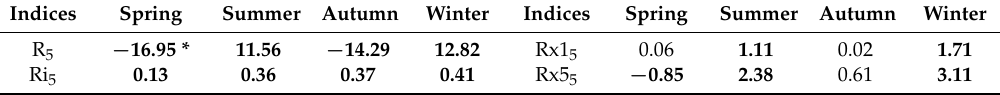
Table 5. Trends for the 5-year return levels for the four precipitation indices (mm · year − 1 · decade − 1 ). Indices Spring Summer Autumn Winter Indices Spring Summer Autumn Winter